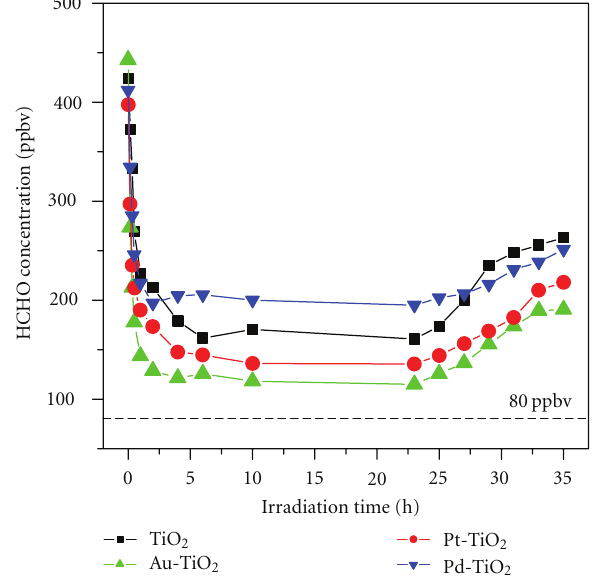
Figure 5: Time courses for the outlet concentration of formalde- hyde with irradiation time in the 35h UV 254nm photocatalysis.